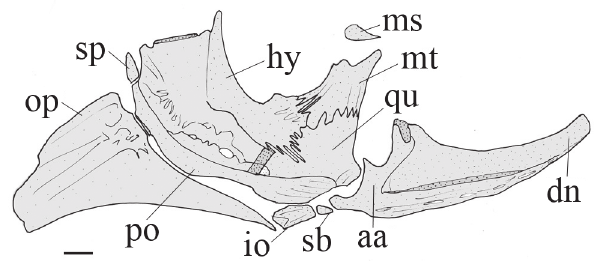
Fig. 3. Right suspensorium of Glanidium botocudo , MNRJ 32539, paratype, 82.0 mm SL. Lateral view. Abbreviations: aa, angulo-articular; dn, dentary; hy, hyomandibula; io, interopercle; mt, metapterygoid; ms, mesopterygoid; op, opercle; po, preopercle; qu, quadrate; sb, subpreopercle; sp, suprapreopercle. Scale bar = 1.0 mm.